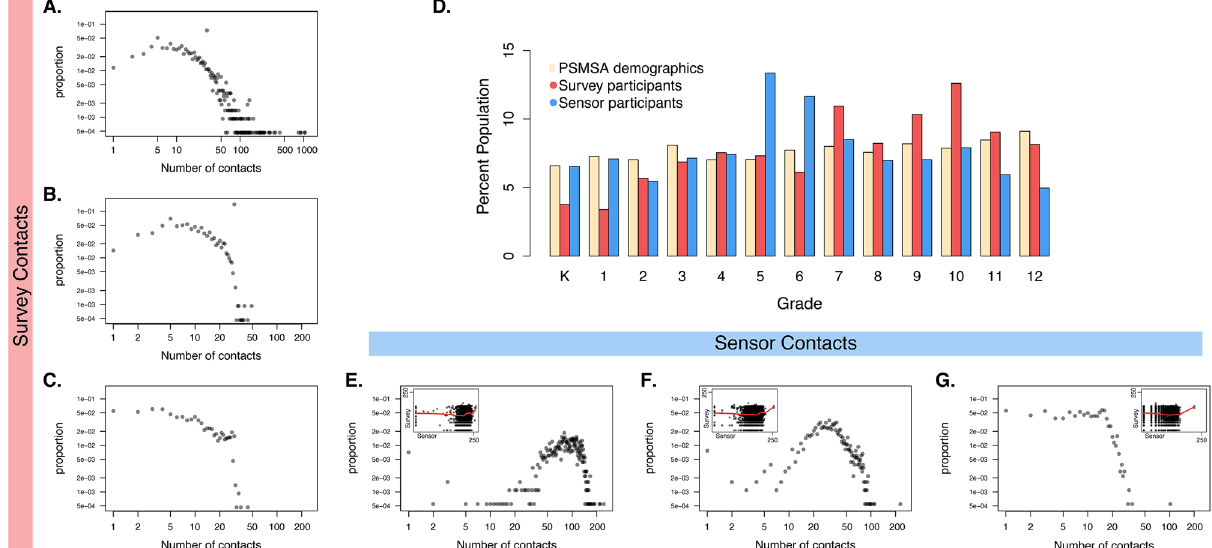
Figure 1. Distribution of the number of contact events recorded in a US school setting by self-reported contact surveys and proximity-detecting sensors: ( A ) total survey-reported contacts; ( B ) detailed survey-reported contacts; ( C ) survey-reported in-school contacts; ( E ) all unique contacts recorded by sensors; ( F ) all unique contacts with more than 10 cumulative contacts (roughly 3 min of interaction); and ( G ) all unique contacts with more than 100 cumulative contacts (roughly 30 min of interaction). Insets in ( E – G ) show the plot of in-school survey contacts versus each metric of sensor-recorded contacts with a cubic smoothing spline. ( D ) shows the population distribution by grade of participants who completed at least one contact survey or participated in a sensor deployment, compared to the population distribution of the Pittsburgh standard metropolitan statistical area (PSMSA) for